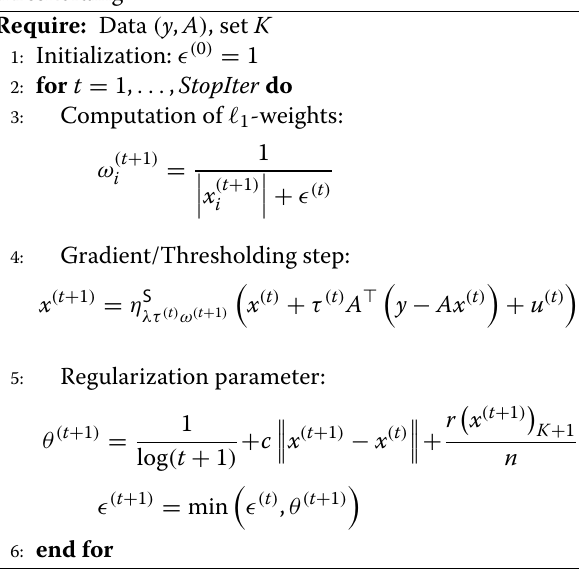
Algorithm 2 IRL1 - tuned iterative shrinkage-